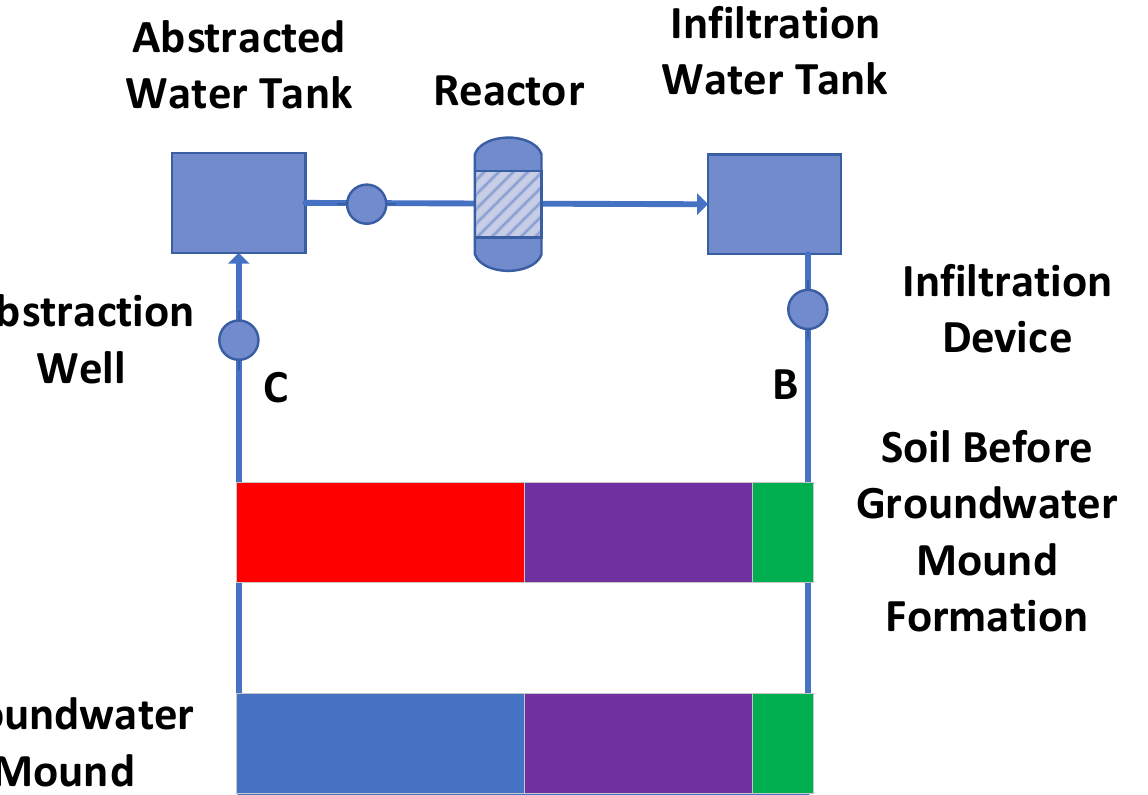
Figure A3. Process flow diagram associated with creating and operating a stationary groundwater mound in contaminated soil. Green = S air ; Red = S a ; Purple = S wir , Blue = S w .